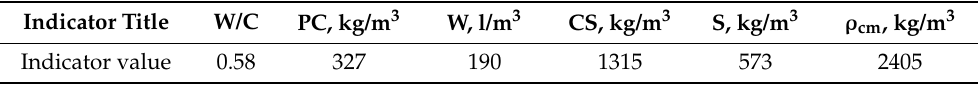
Table 7. Parameters of the composition of the concrete mixture.